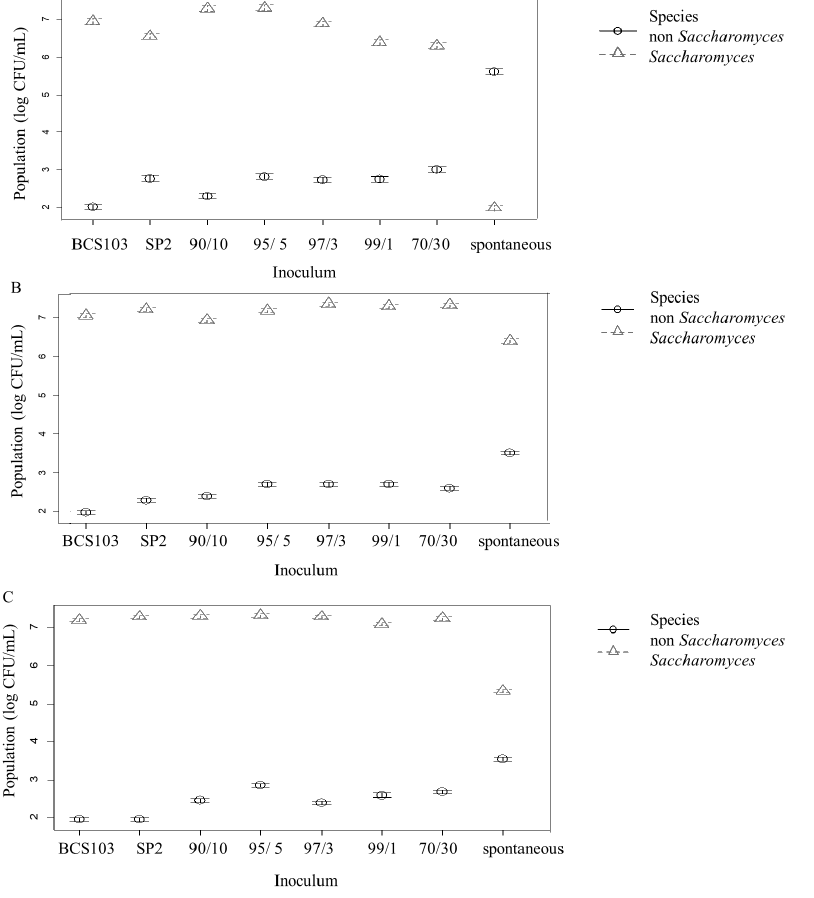
Figure 1. Evolution of Saccharomyces and non- Saccharomyces populations (in log CFU/mL) during alcoholic fermentation of Sauvignon Blanc must after 48 h ( A ), 2/3 of the process ( B ) and at the end of fermentation ( C ). The must was fermented under different inoculation schemes using S. bayanus BCS103 (BCS103) and S. pastorianus SP2 (SP2) as monoculture and co-inoculation of S. pastorianus SP2 and S. bayanus BCS103 at a ratio of 90/10, 95/5, 97/3, 99/1 and 70/30. The condition with no inoculation scheme was also tested (spontaneous).